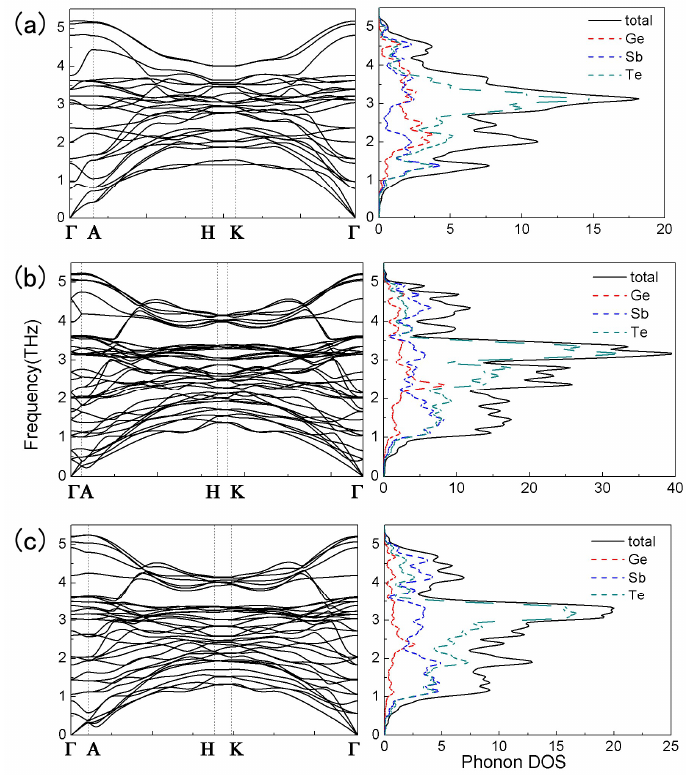
Figure 3. Phonon dispersion relations and phonon density of states for hexagonal GST compounds: